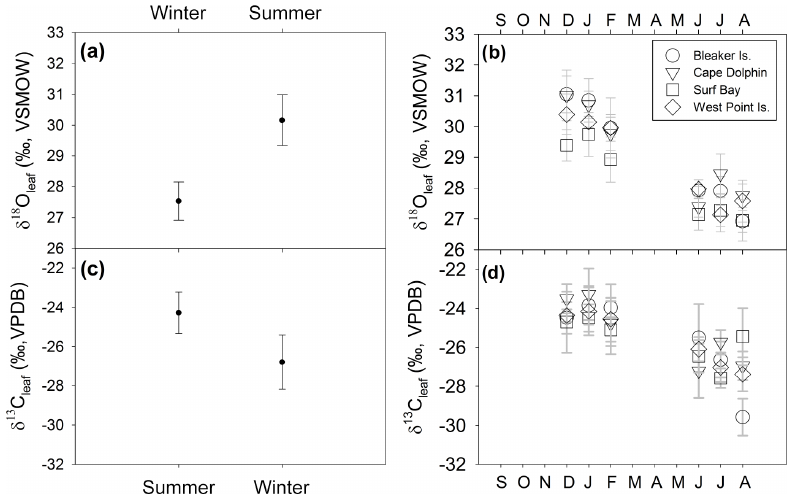
Figure 6. δ 13 C leaf and δ 18 O leaf of Poa flabellata . (a) δ 18 O leaf (‰) comparison (mean ± 1SD) between summer (DJF) and winter (JJA) and (b) at four study sites over 1 year. (c) δ 13 C leaf (‰) comparison (mean ± 1SD) between summer and winter and (d) at four study locations over 1